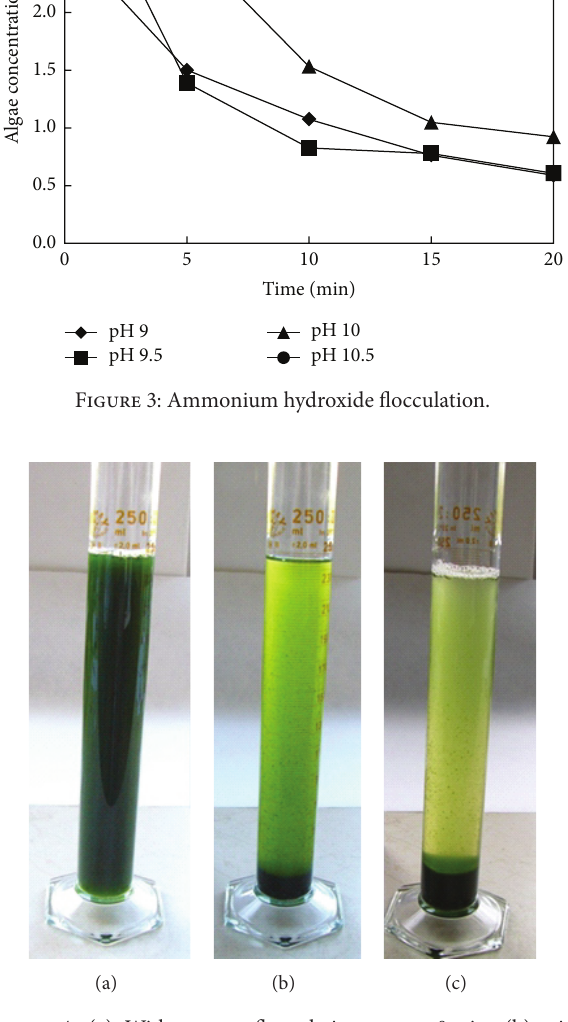
Figure 4: (a) Without any flocculation agent, 0min; (b) with NH 4 OH, pH 9, after 20min; (c) with chitosan 5 g/L, after 20